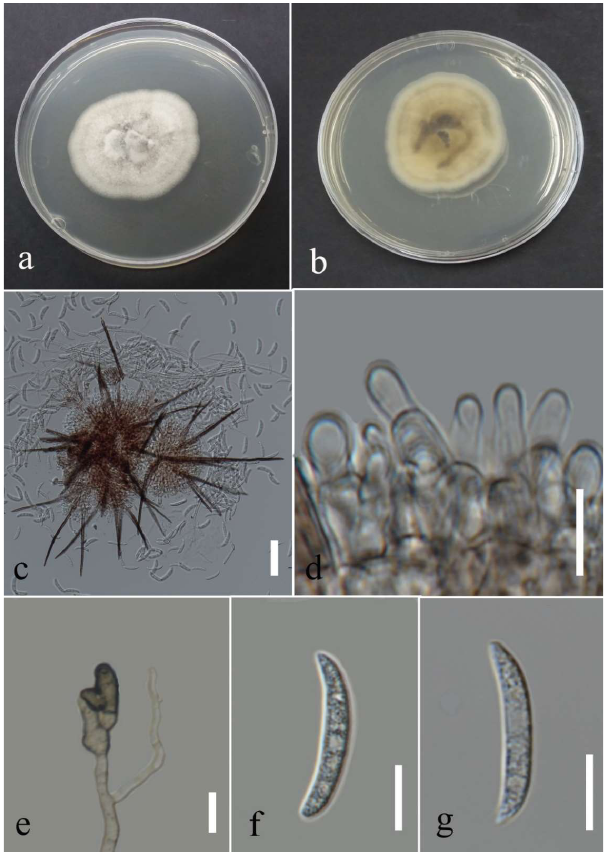
Figure 32. Morphology of Colletotrichum truncatum (MFLUCC 22-0177) obtained from Cyclosorus sp.: ( a , b ) upper and reverse views of the colony after seven days growth on PDA at 28 °C; ( c ) acervulus and setae; ( d ) conidiogenous cells; ( e ) appressoria; ( f , g ) fulcate conidia. Scale bars ( c ) = 50 µm and ( d – g ) = 10 µm.